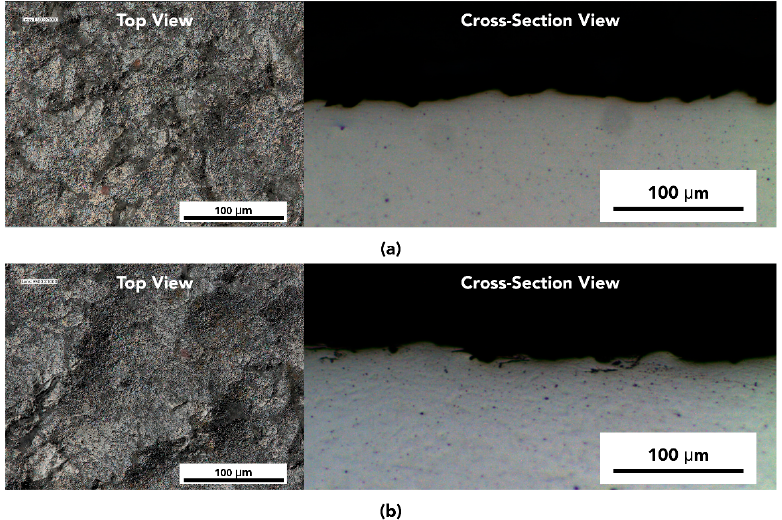
Figure 17. The images of the shot blasted surfaces: ( a ) 309L cladding; ( b ) A36—A36 substrate.